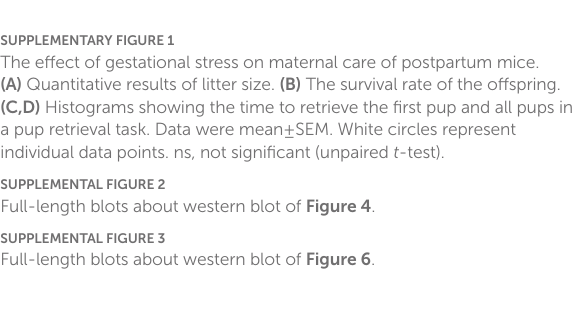
SUPPLEMENTARY FIGURE 1 The effect of gestational stress on maternal care of postpartum mice. (A) Quantitative results of litter size. (B) The survival rate of the offspring. (C,D) Histograms showing the time to retrieve the first pup and all pups in a pup retrieval task. Data were mean ± SEM. White circles represent individual data points. ns, not significant (unpaired t -test). SUPPLEMENTAL FIGURE 2 Full-length blots about western blot of Figure 4 . SUPPLEMENTAL FIGURE 3 Full-length blots about western blot of Figure 6